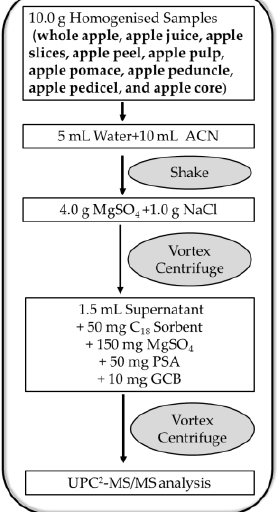
Figure 5. Diagram of analytical procedure including extraction and purification steps.